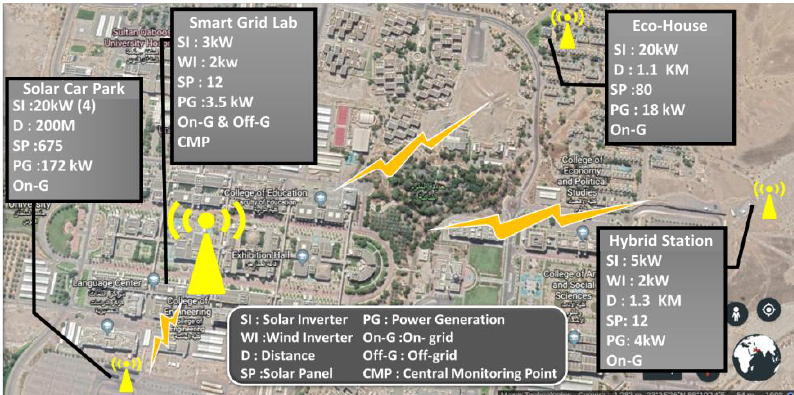
Figure 1. Locations of the renewable energy systems at the Sultan Qaboos University campus. The figure is annotated with information about Solar Inverters (SI), Wind Inverters (WI), Distance (D), Solar Panels (SP), Power Generation (PG), On-Grid (On-G), Off-Grid (Off-G), and Central Monitoring Point (CMP).